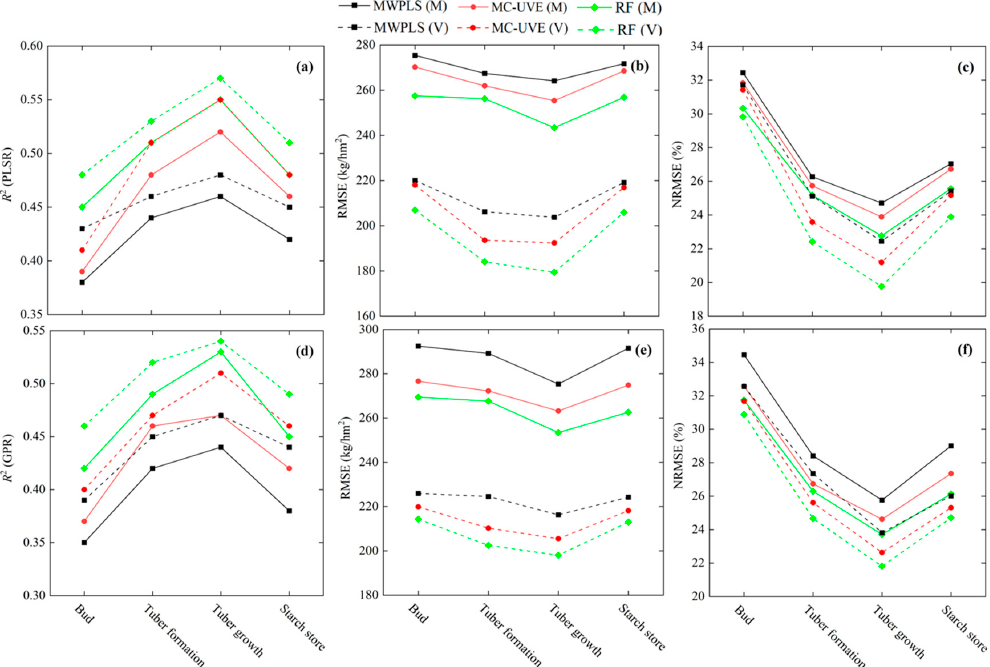
Figure 7. Accuracy of estimating AGB based on the feature variables screened from CRS by MWPLS, MC-UVE and RF. ( a – c ) The R 2 , RMSE (kg/hm 2 ) and NRMSE (%) of AGB was estimated using the PLSR method. ( d – f ) The R 2 , RMSE (kg/hm 2 ) and NRMSE (%) of AGB was estimated using the GPR method.